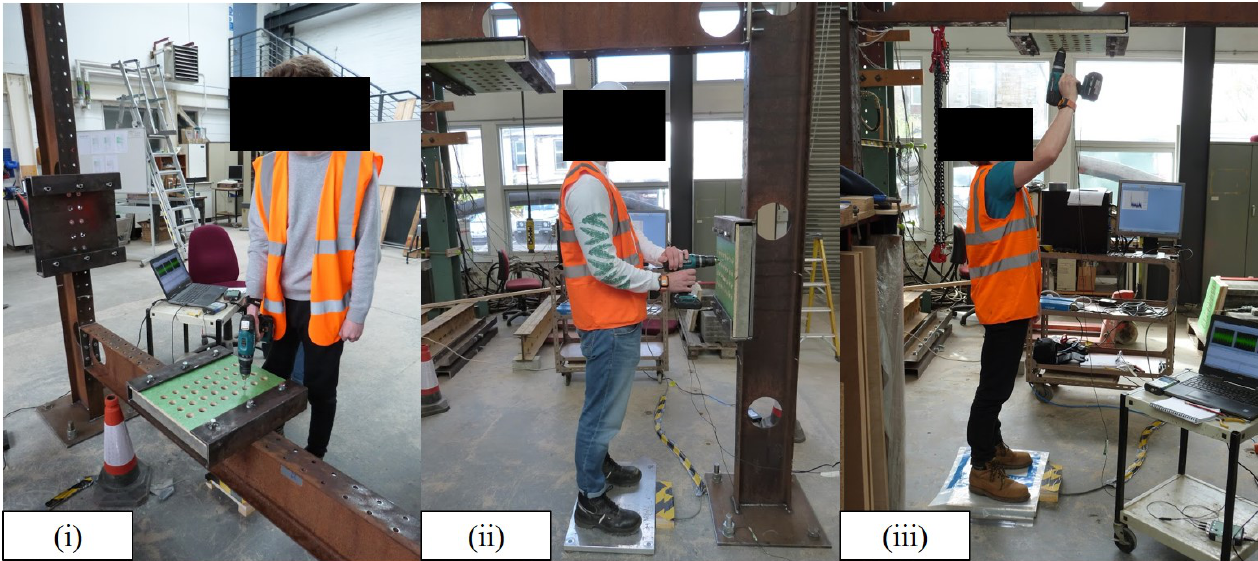
Figure 2. Test postures ( i ) vertical downwards similar to ISO 28527-5 posture, ( ii ) horizontal and ( iii ) vertical